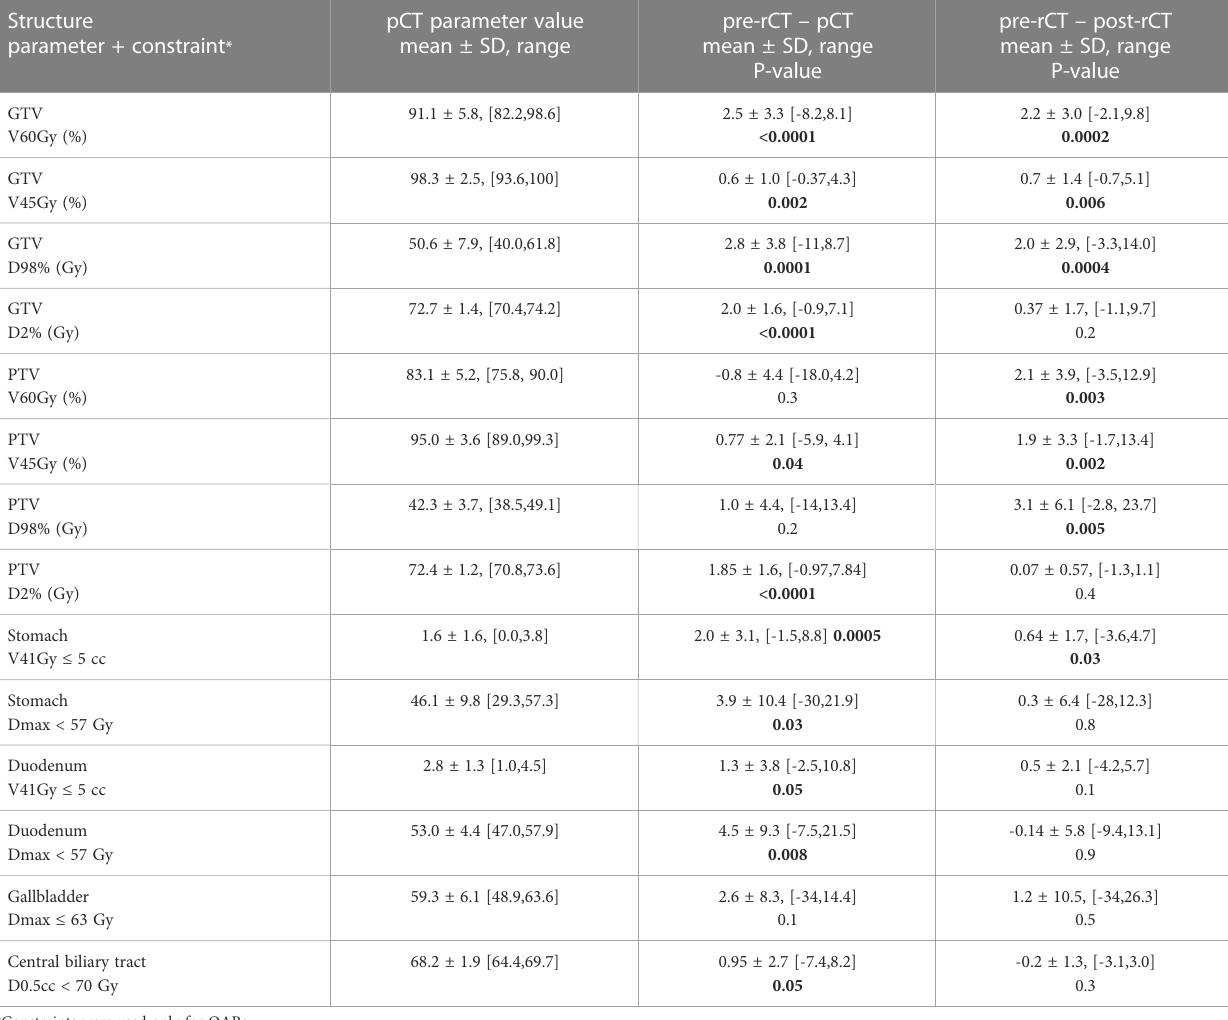
TABLE 1 1st data column: Mean dosimetric GTV, PTV and OAR plan parameter values in the pCT for the 6 study patients. 2nd data column: Plan parameter differences between pre-rCTs and corresponding pCTs.